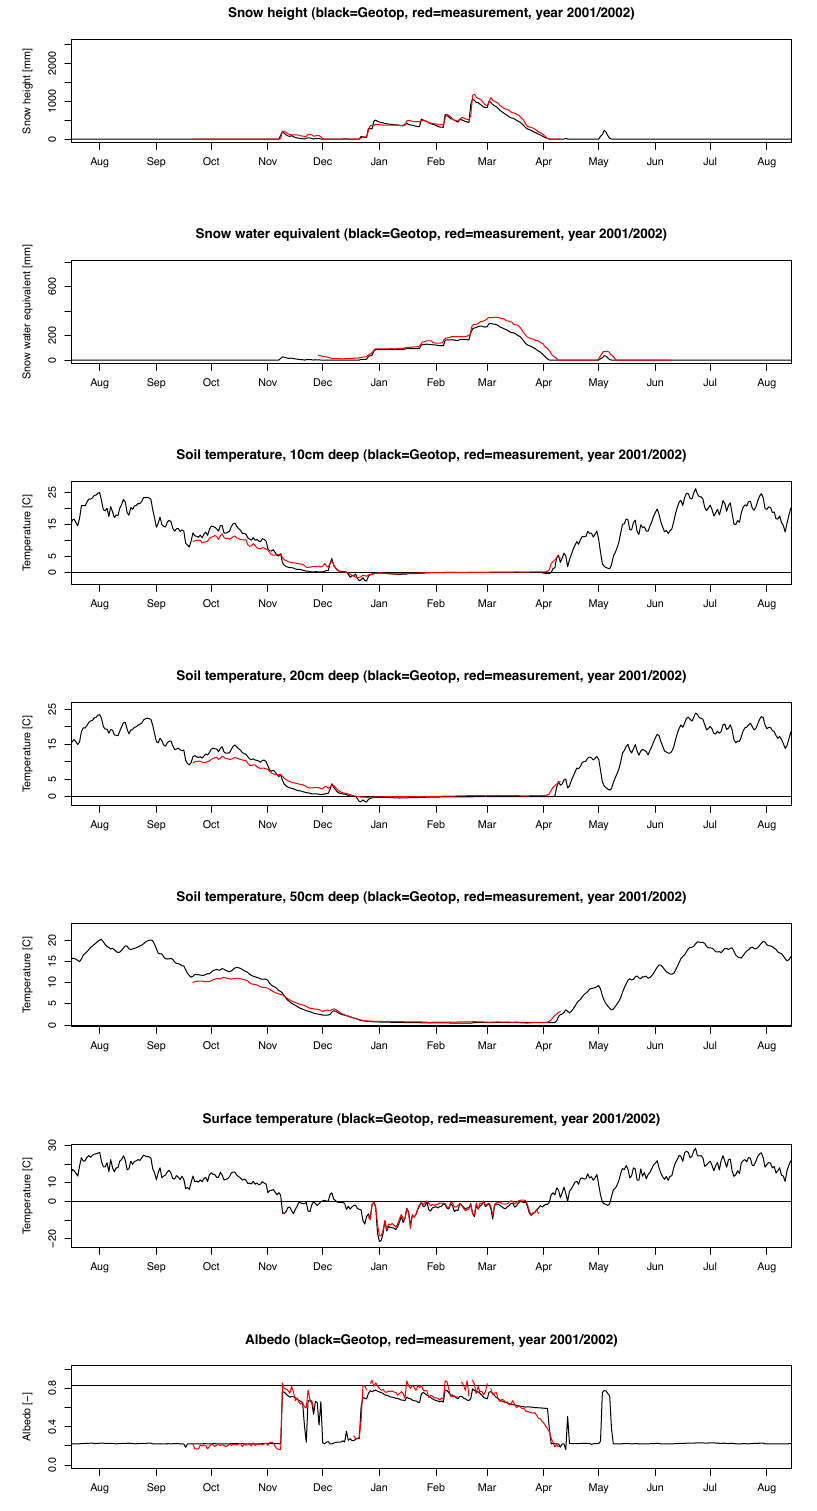
Figure 2. Snow model testing: comparison of measured (red line) and simulated (black line) results at Col de la Porte (Morin et al., 2012) in the year 2001–2002. Starting from top to bottom, snow height, snow water equivalent, soil temperature at 10cm depth, 20cm depth, 50cm depth, ground surface temperature and albedo comparisons are